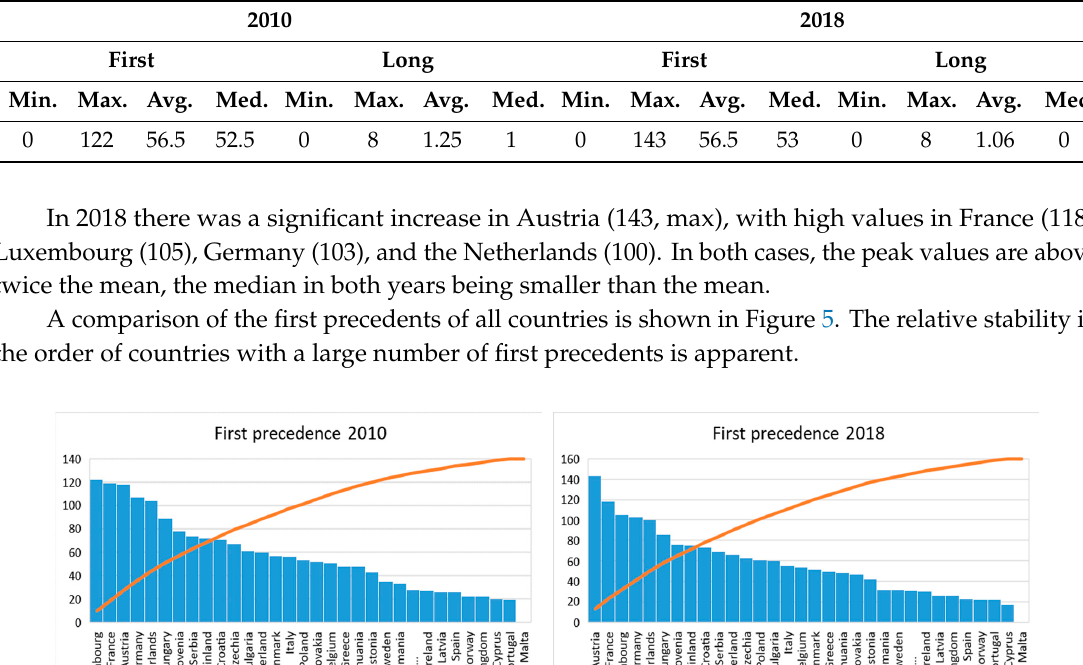
Figure 5. Number of the first precedencies by country in 2010 and 2018—geospatial distribution.